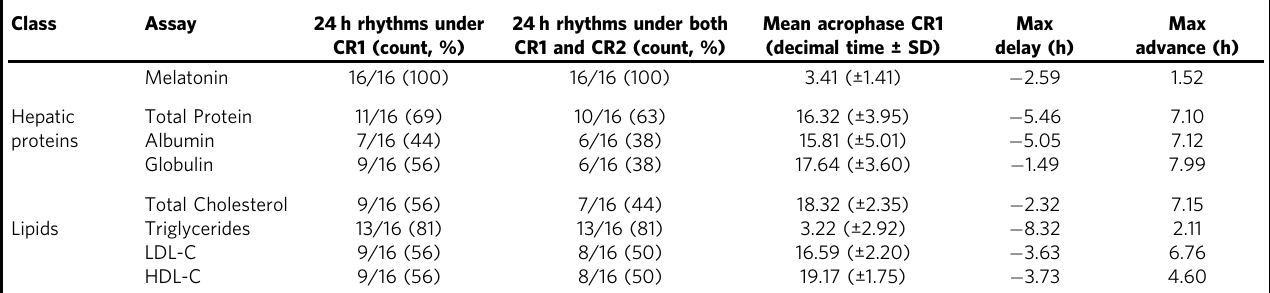
Table 1 Summary of endogenous rhythmicity and phase